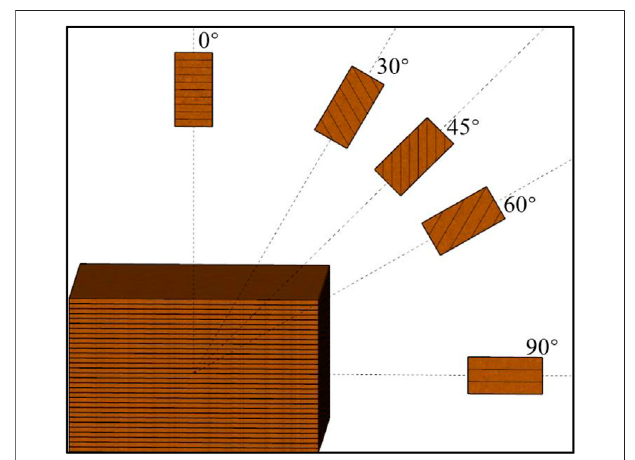
FIGURE 1 | Schematic diagram of rock sample